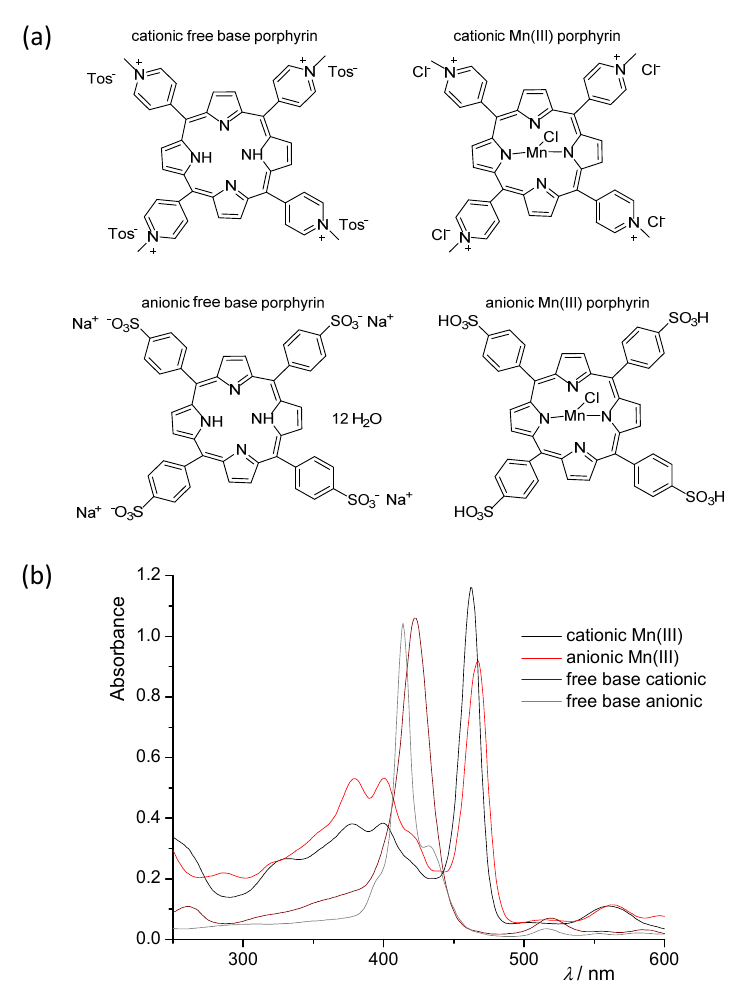
Figure 2. Structures of the used porphyrins ( a ) and their UV/Vis absorption spectra in water ( b ).